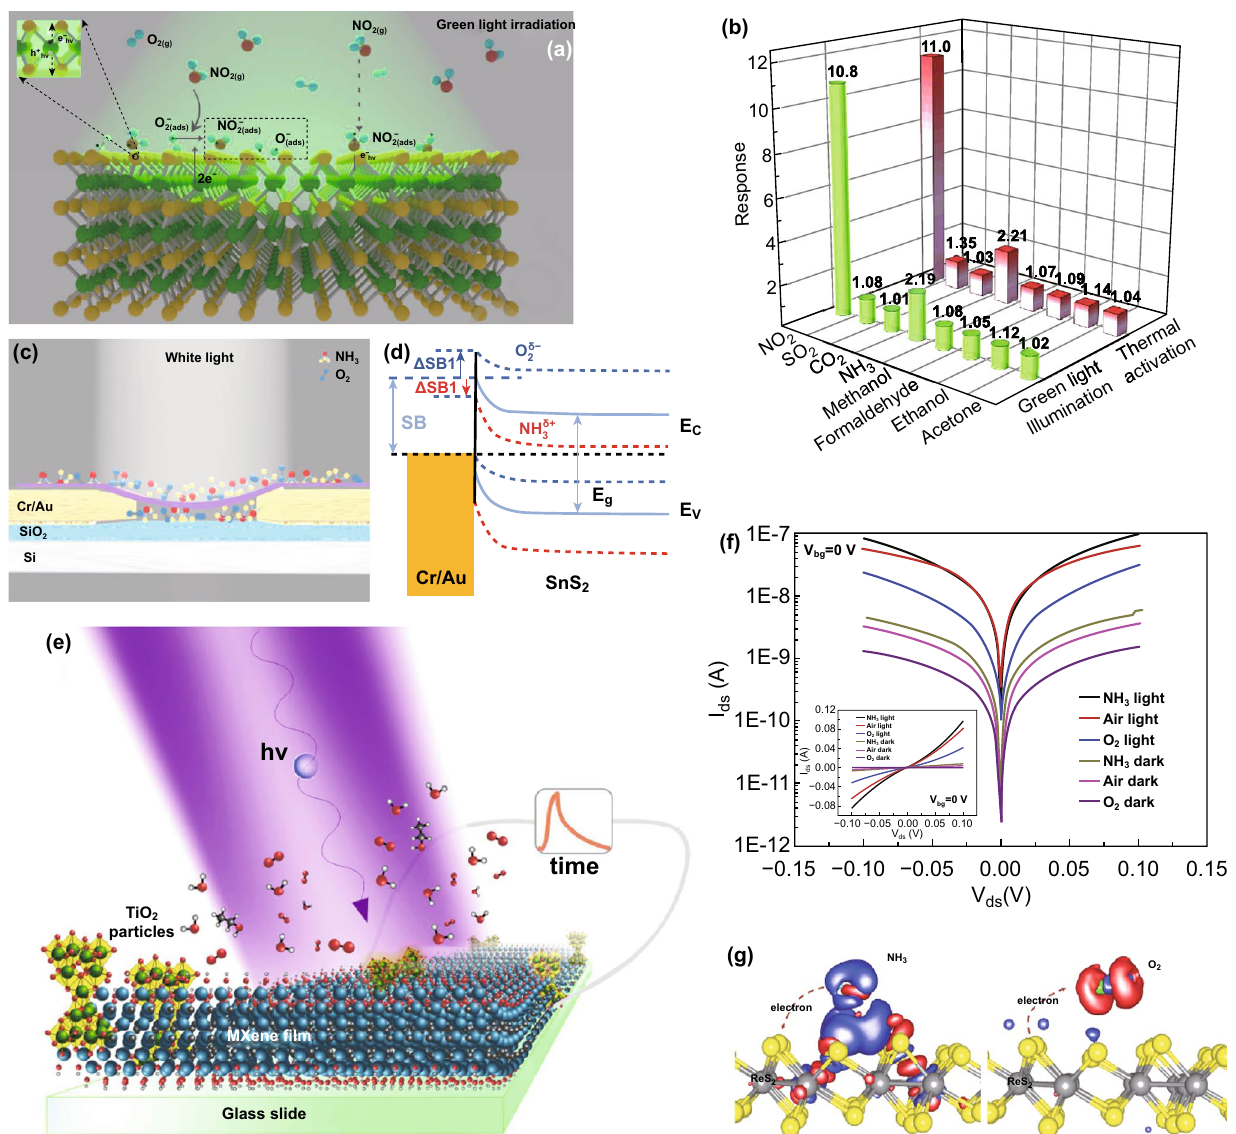
Fig. 17 a Schematic representation of gas sensing mechanism of SnS 2 sensor under green light illumination. b Gas response to different gases of the sensor under green light illumination and thermal activation. Reproduced with permission [143]. Copyright 2019, Elsevier. c Schematic illustration of the suspended SnS 2 -based device under white light illumination. d Gas sensing mechanism of the SnS 2 sensor based on modula- tion of Schottky barrier upon exposure to NH 3 . Reproduced with permission [145]. Copyright 2018, WILEY ‐ VCH Verlag GmbH & Co. KGaA, Weinheim. e Schematic of MXene gas sensor under UV light illumination. Reproduced with permission [152]. Copyright 2018, American Chemical Society. f Current versus voltage of the suspended ReS 2 sensor in different gas ambient. g Charge transfer between ReS 2 and NH 3 or O 2 . Reproduced with permission [148]. Copyright 2016, WILEY ‐ VCH Verlag GmbH & Co. KGaA,